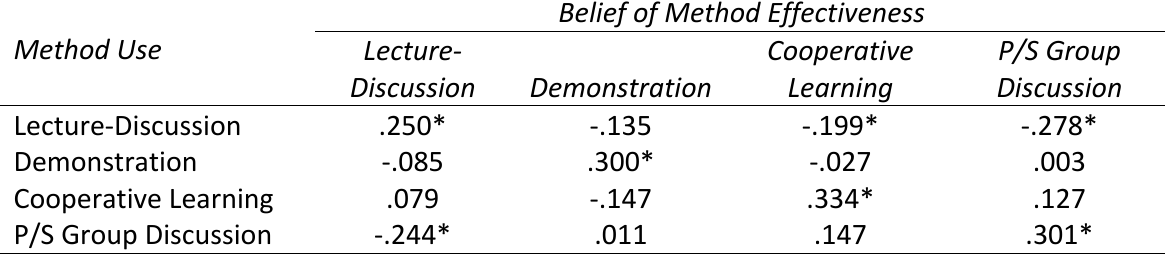
Zero Order Correlations between Method Use and Belief of Method